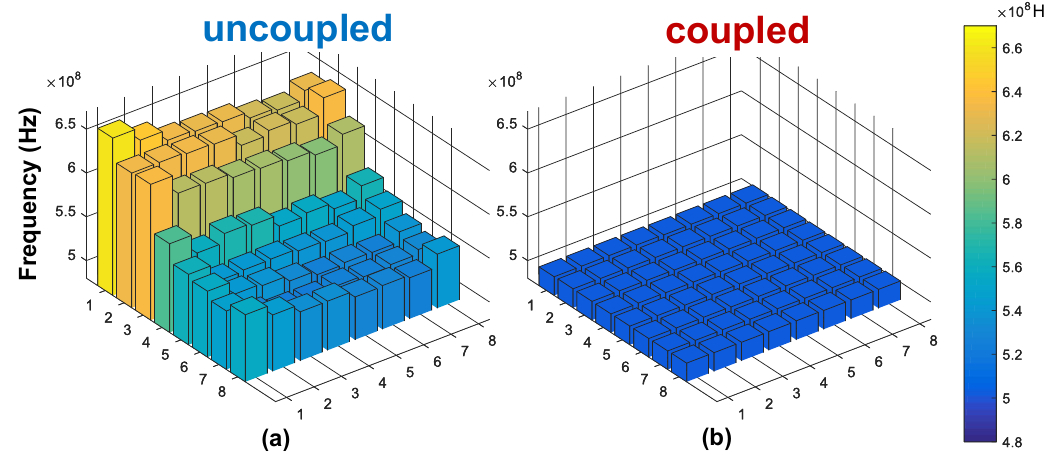
Figure 16. Individual frequencies for different modes: ( a ) uncoupled; ( b )